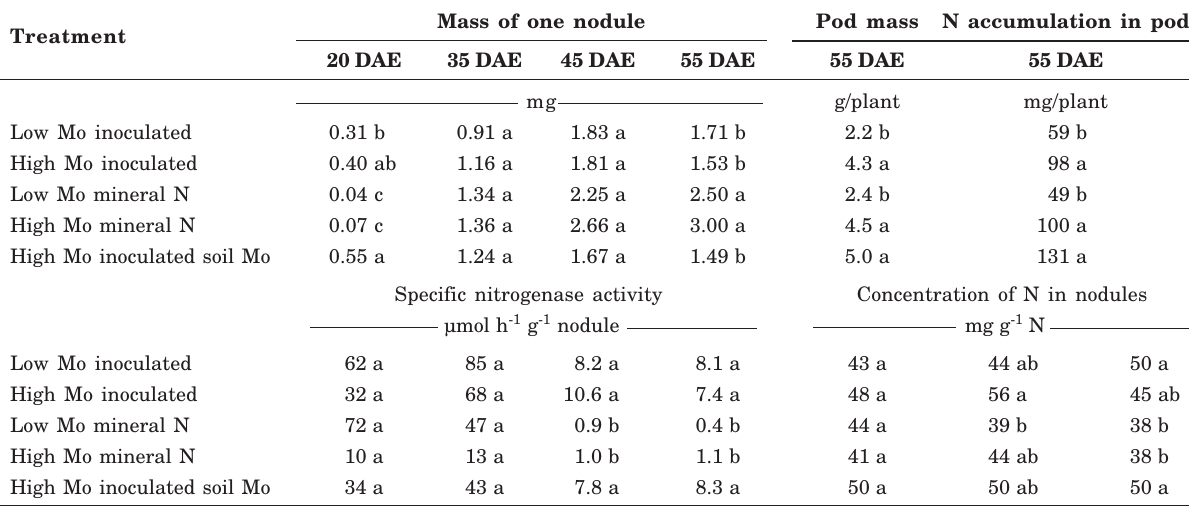
Means followed by the same letter in columns do not differ by Tukey’s test at 0.05 probability. Concentration of N in nodules was not measured 20 DAE due to little material available.